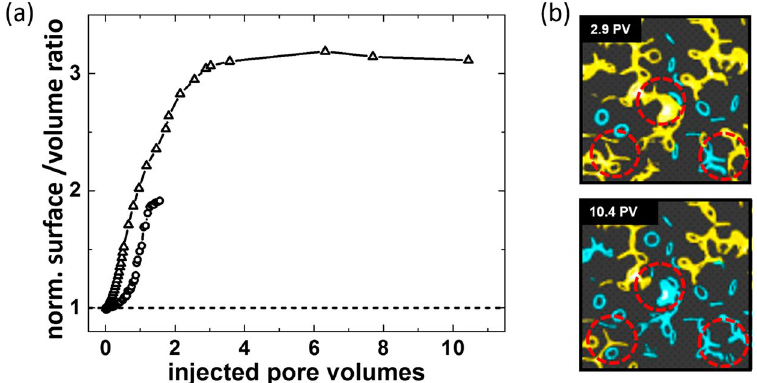
Figure 6. Surface–to–volume ratio of the percolated oil phase during a water flood. ( a ) Symbols display the ratio a / a 0 of the surface–to–volume ratio a of the defending phase to the value a 0 for a random close pack of beads initially fully saturated with the defending phase. Shown are data for basalt (circles) and glass (triangles) with contact angles θ ≈ 75° and θ ≈ 125°, respectively, as a function of the injected pore volume. ( b ) Three- dimensional volume rendering of the defending phase during aqueous phase injection into glass beads after 2.9 and 10.4 injected pore volumes. Areas where the disconnection of ganglia during drainage of defending phase are clearly visible are indicated by